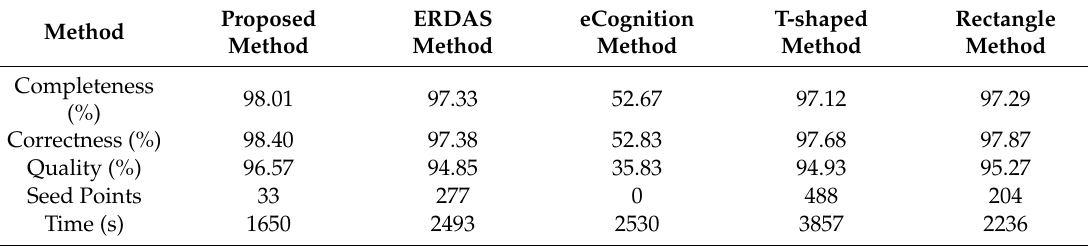
Table 3. Accuracy evaluation of the second study